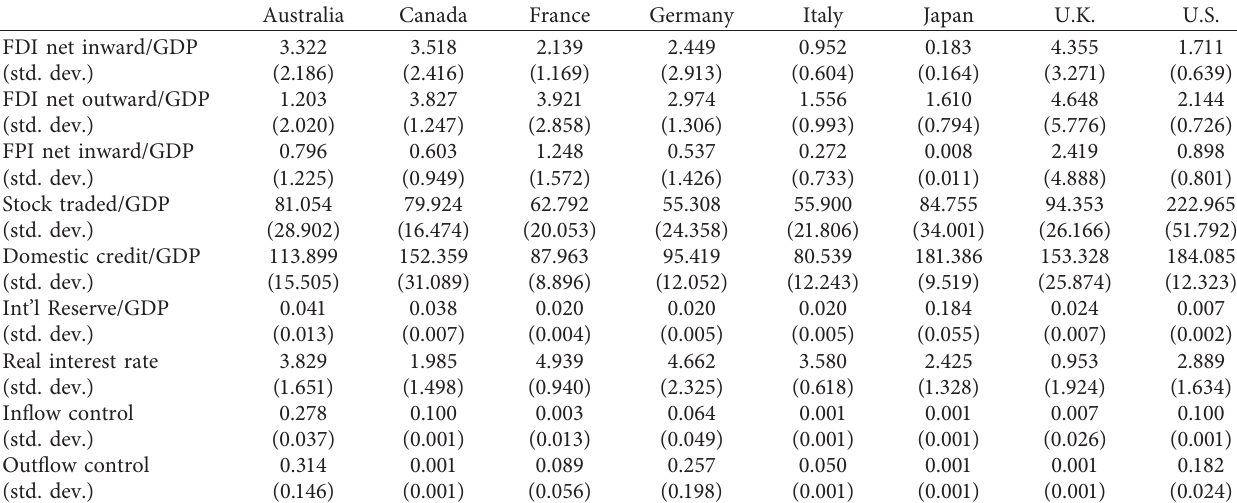
Table 2: Descriptive statistics in eight developed